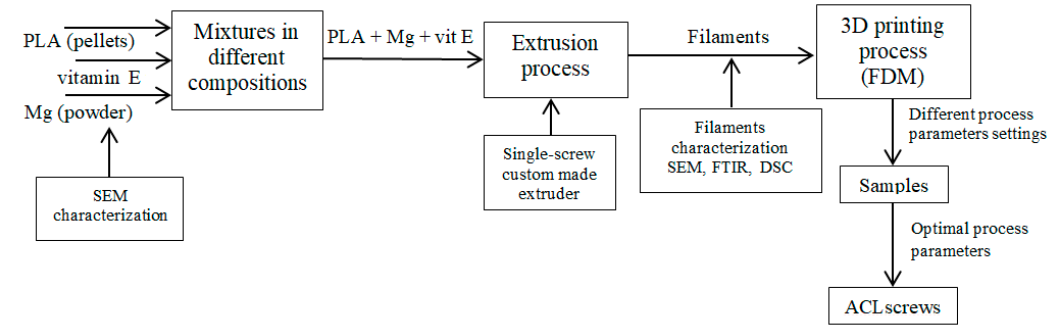
Figure 1. The process of manufacturing implant screws from Mg filled PLA composite.